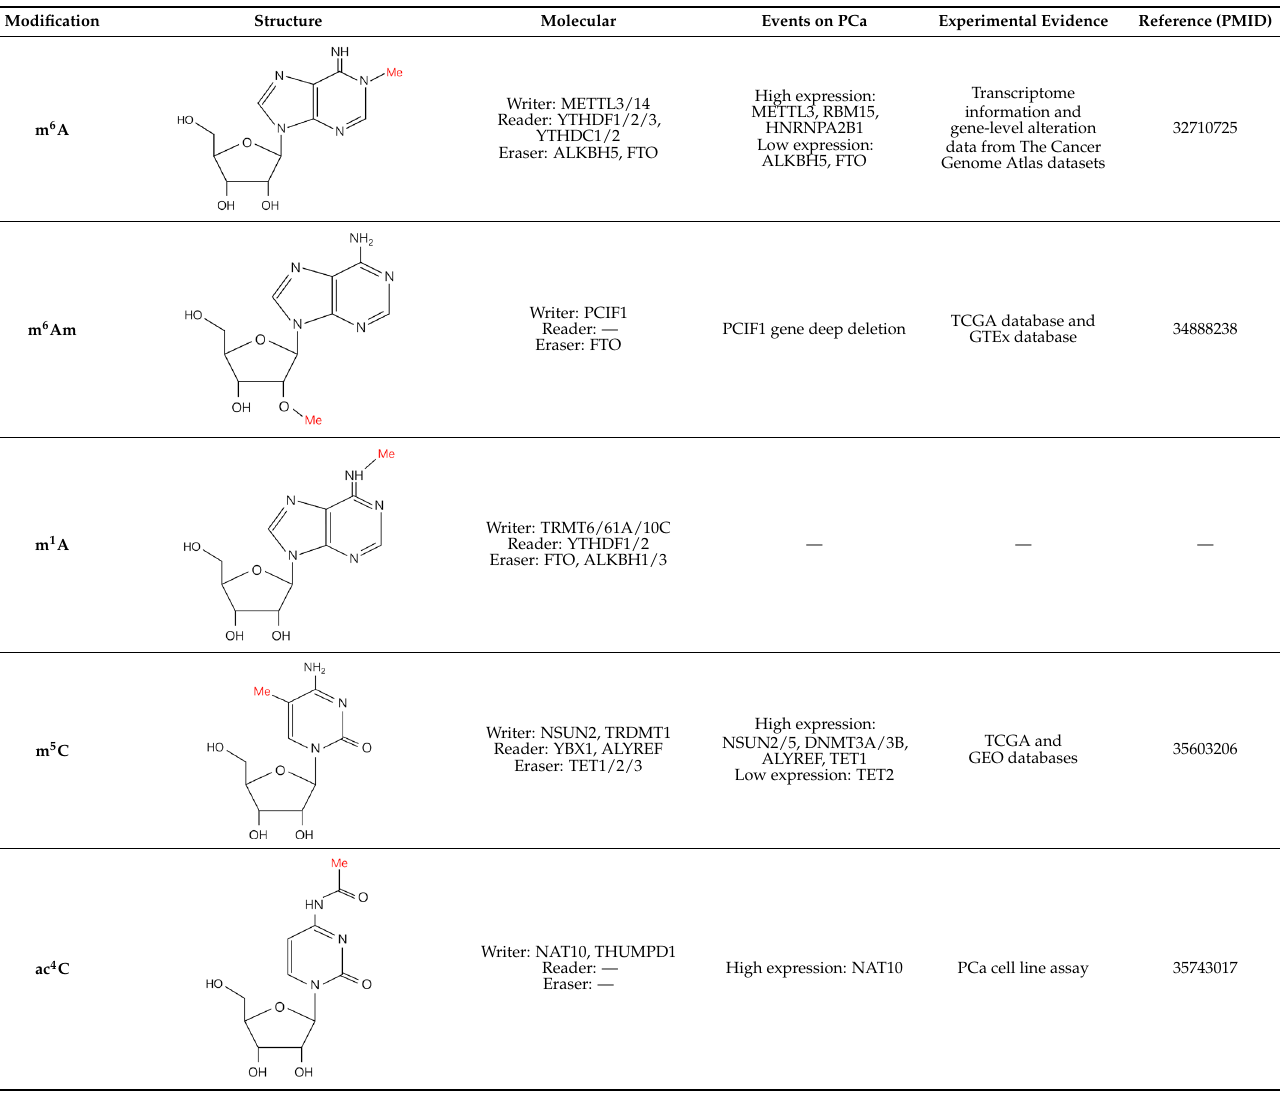
Table 1. Epigenetic modification events in prostate cancer.